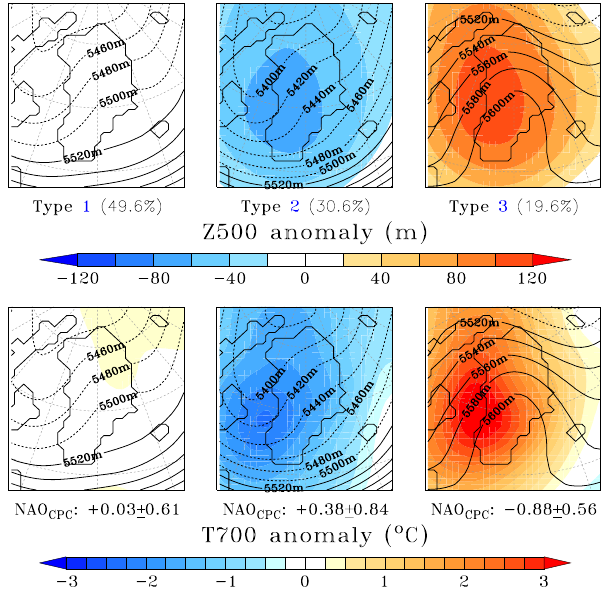
Fig. 3. (Top) The Z500 average over the days categorized into the 3 classes minus the JJA Z500 average over the whole period 1958–2012. The solid lines (Z500 > 5500m) and the dashed lines (Z500 ≥ 5500m) denote the Z500 type-average. For each circula- tion type, the proportion of days contained in that class compared to the 5060 days of the 1958–2012 JJA months is indicated in brack- ets. (Below) The lower panels show much the same but for T700. The daily mean NAO index from CPC when the considered circu- lation type occurs is listed. Both Z500 and T700 fields come here from the NCEP-NCAR